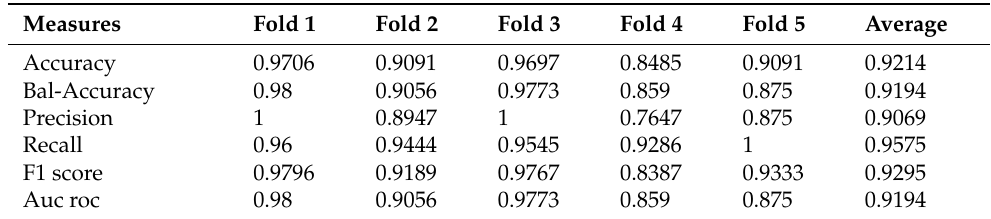
Table 5. K-folds performance results using Xception.